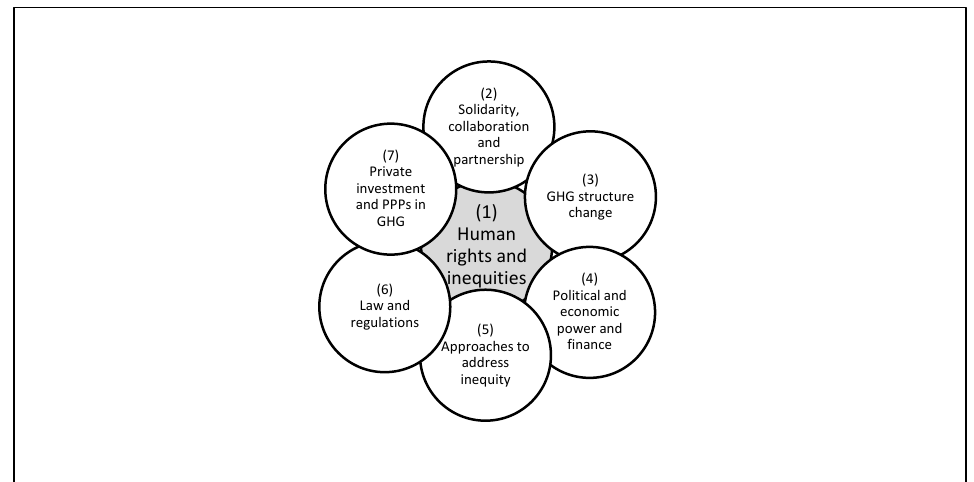
Figure 2. The interlinkages between themes discussing GHG, equity, and COVID-19.